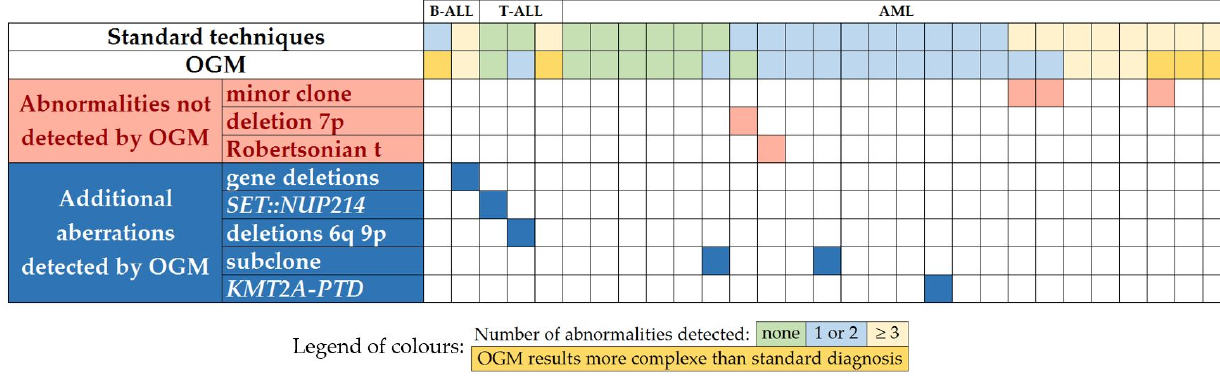
Figure 1. Comparison of routinely used standard techniques and OGM results.